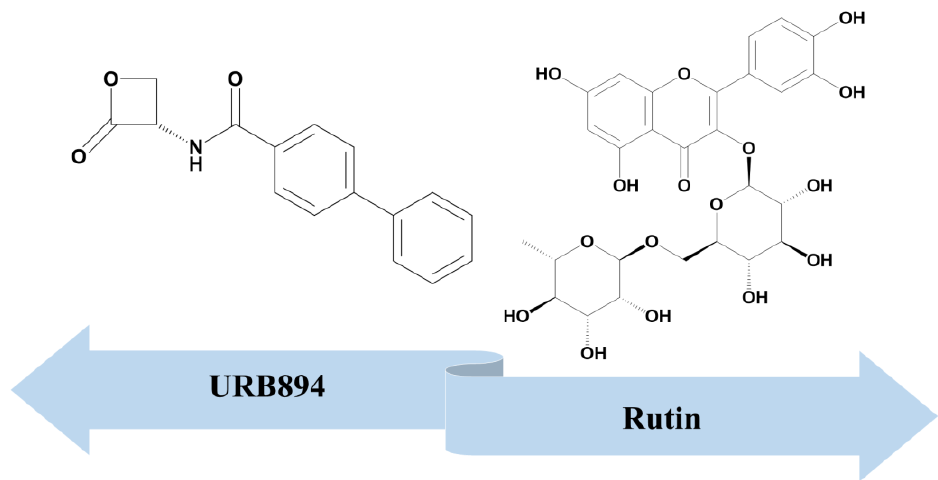
Figure 1. Chemical structures of the compounds co-encapsulated within PLGA nanoparticles.